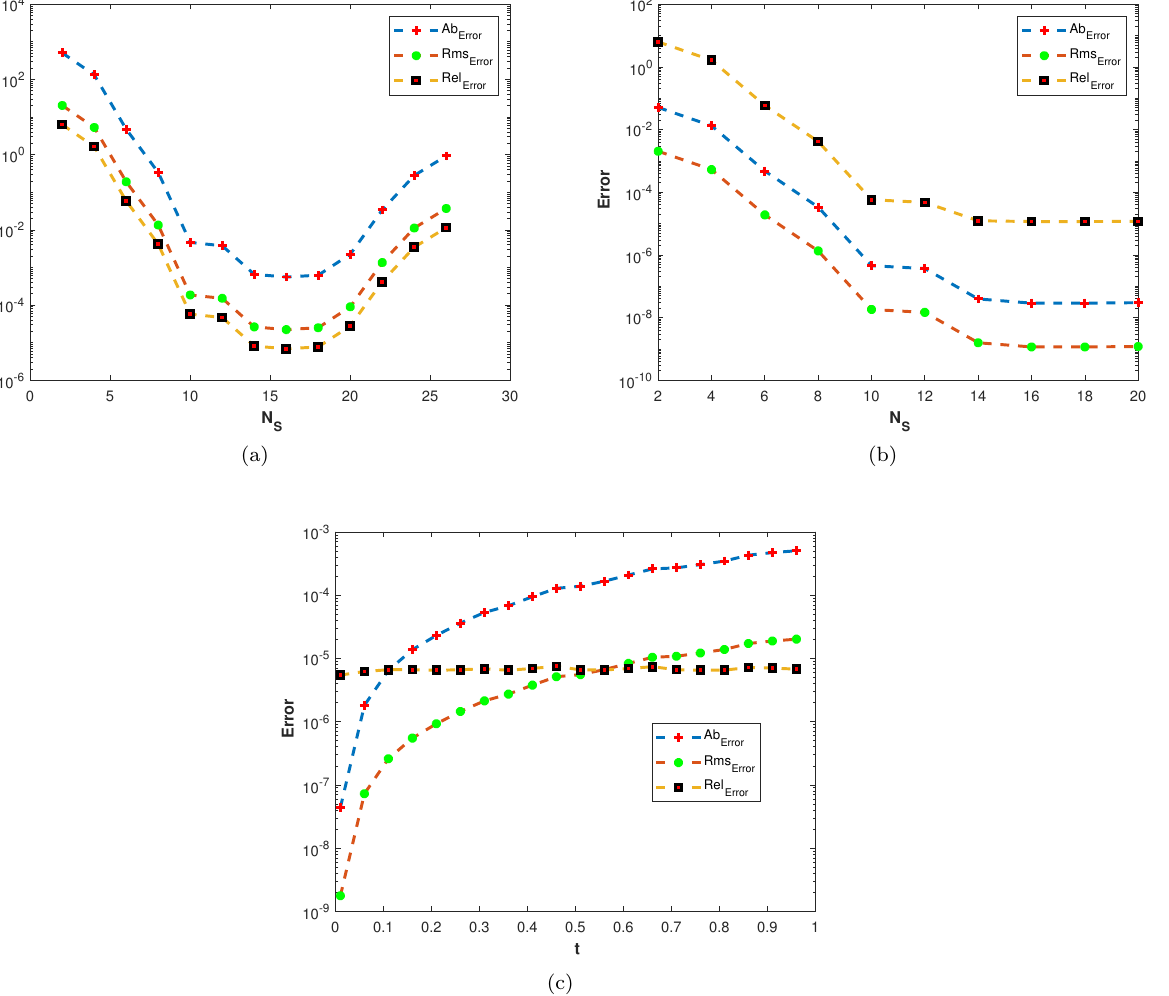
Figure 8. Rms Error of the proposed method computed using Figure 8: Rms Error of the proposed method computed using corresponding to problem 2. corresponding to problem 2.